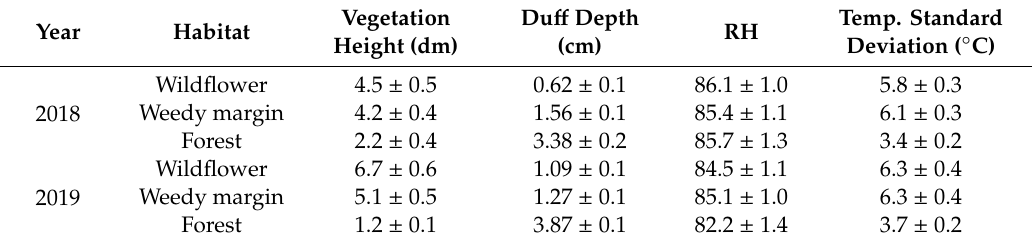
Table 2. Yearly averages (mean ± std. error) of environmental factors measured at each sampling